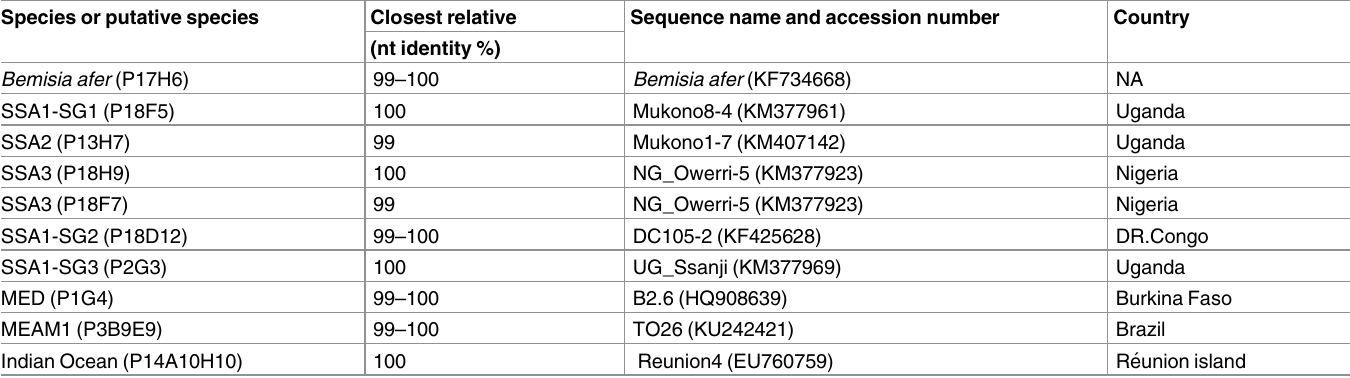
Table 2. Result of the blast algorithm of GenBank when comparing the most frequent haplotypes from CAR to the worldwide diversity. Species or putative species